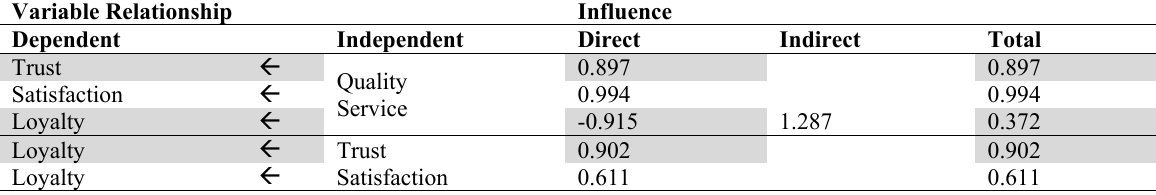
Test Results Analysis of Direct Effects, Indirect Effects and Total Effects Variable